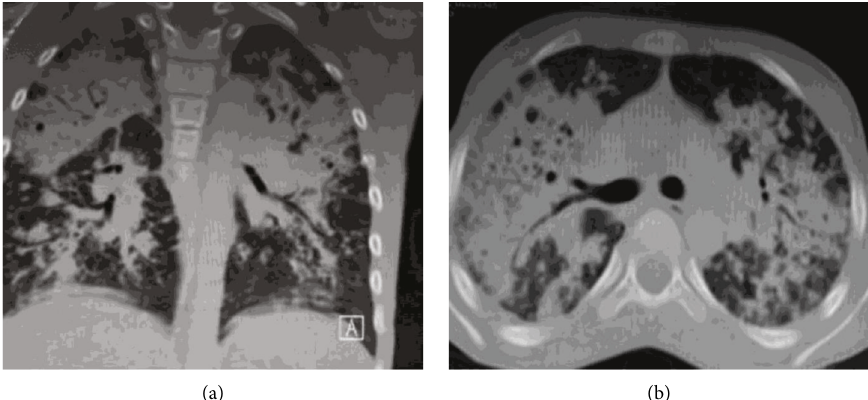
Figure 2: The chest CT scan showed patchy alveolar opacification (a) with multiple superior mediastinal lymph nodes (b).